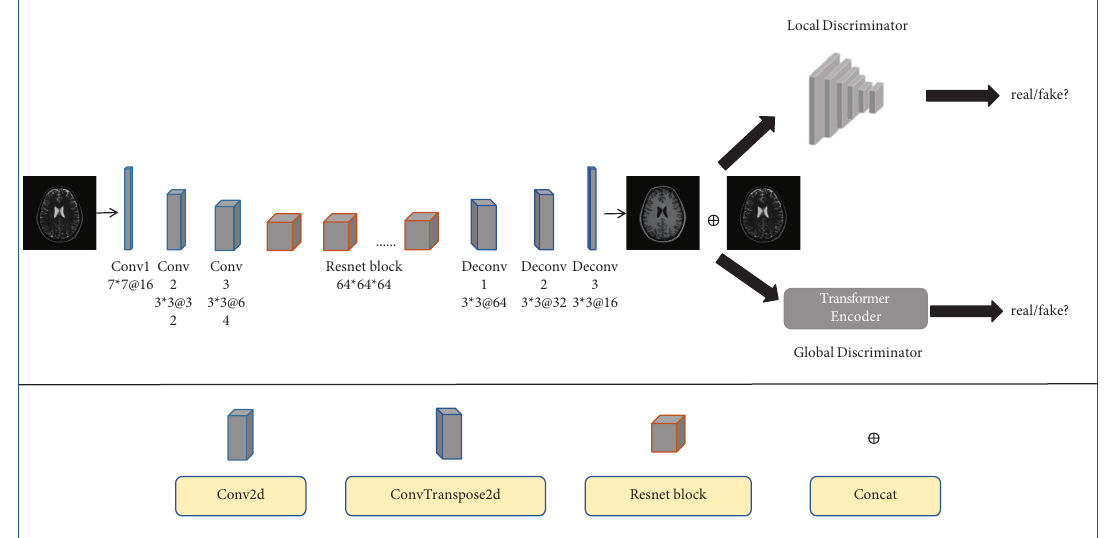
Figure 1: Schematic flow chart of the proposed algorithm for cross-modal medical image synthesis, which consists of generator, CNN-based local discriminator, and transformer-based global discriminator. The local discriminator guides the generator to learn structural repre- sentation with inductive bias. The global discriminator guides the generator to learn comprehensive features by utilizing long-range dependencies between patches of input